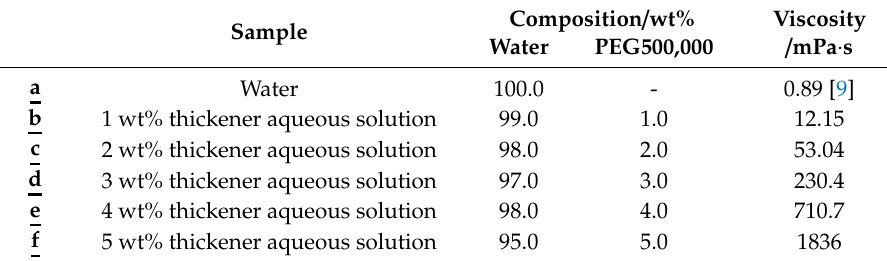
Table 1. Composition of thickened aqueous